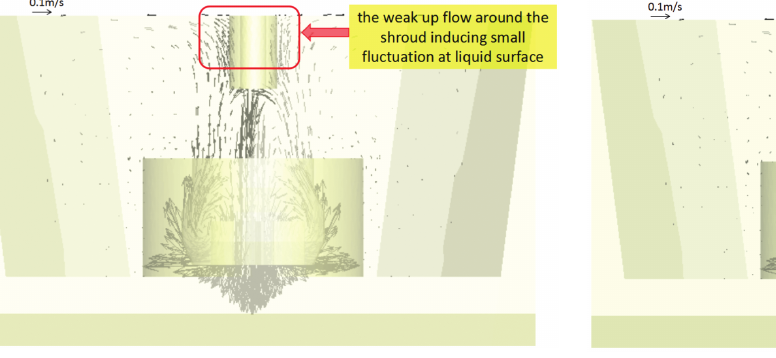
Figure 5: The vector diagram of flow field in impact zone of tundish with traditional TI.